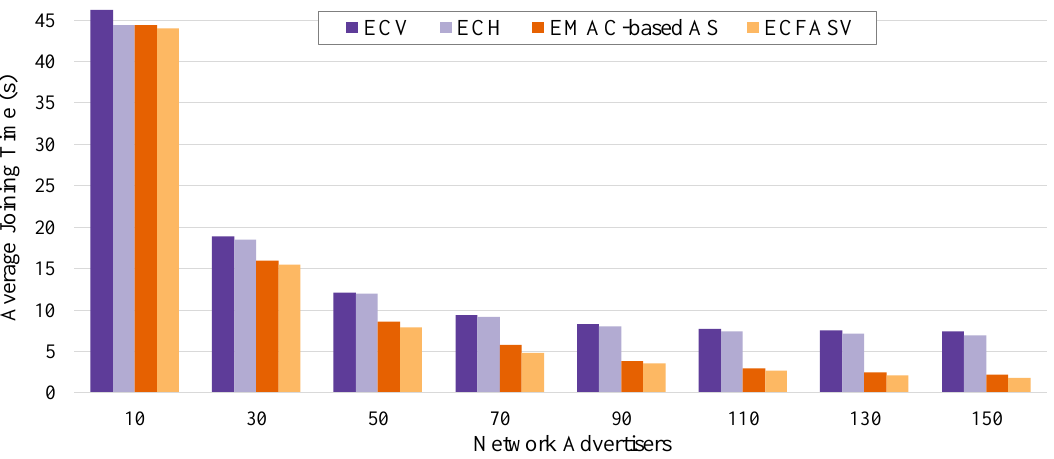
Figure 16. Comparison of ECFASV and its MAC-based alternative with ECV and ECH for a mobile joining